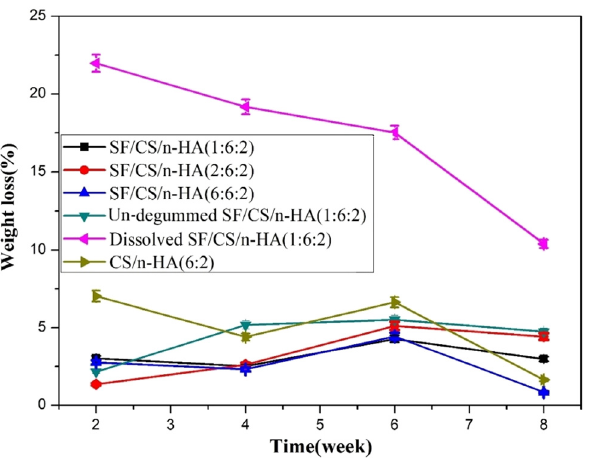
Figure 6: Tensile strength reduction of the composite membranes during the